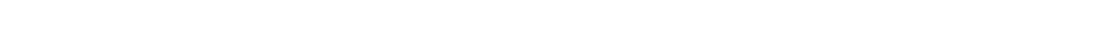
FIGURE 2 | HPLC-MS chromatogram of sterol extracts (A) and schematic representation of the ergosterol biosynthetic pathway (B) in N. crassa